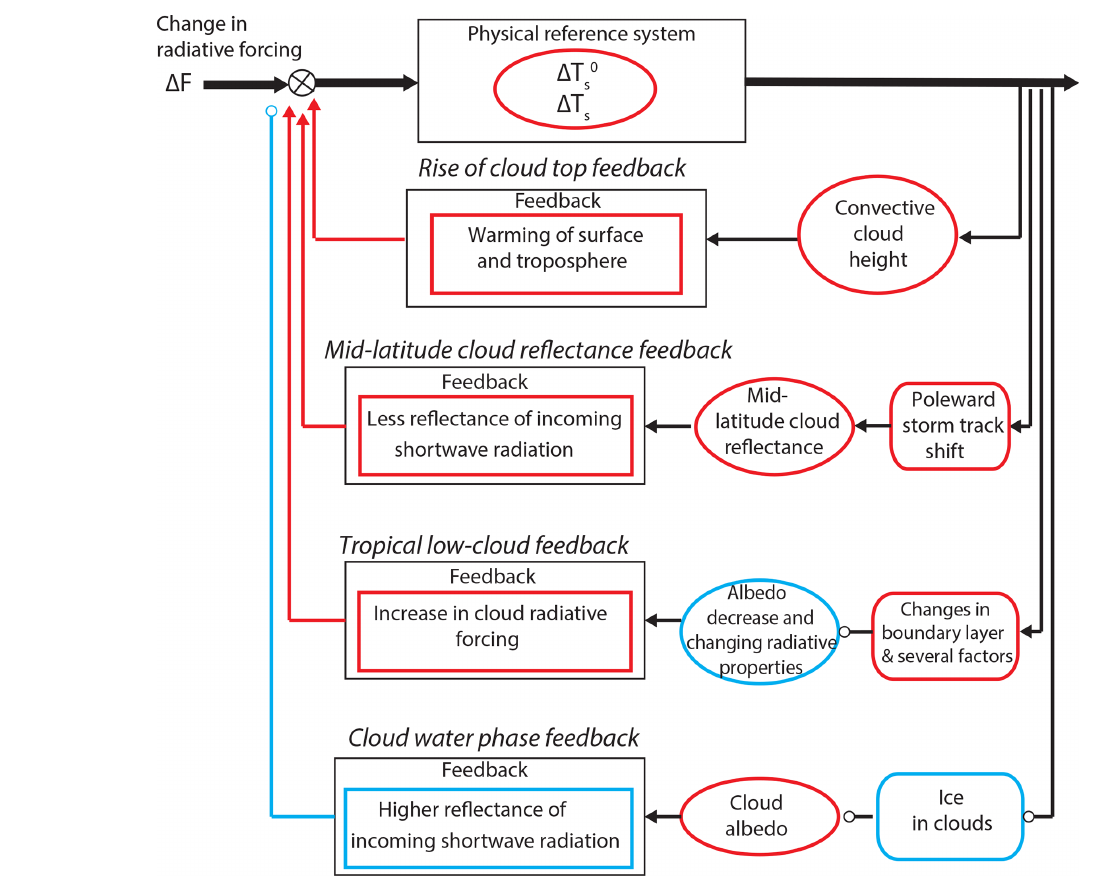
Figure 6. Schematic of important cloud feedbacks. Arrows indicate positive coupling; open circles indicate negative coupling. Changes in state variables are indicated by ellipses; changes in processes by rounded rectangles. Red indicates increasing values of variables, strength- ening of processes, or positive feedbacks; blue indicates the opposite. The change in surface air temperature (cid:49)T s in the presence of feedback is different from the change (cid:49)T 0 s without